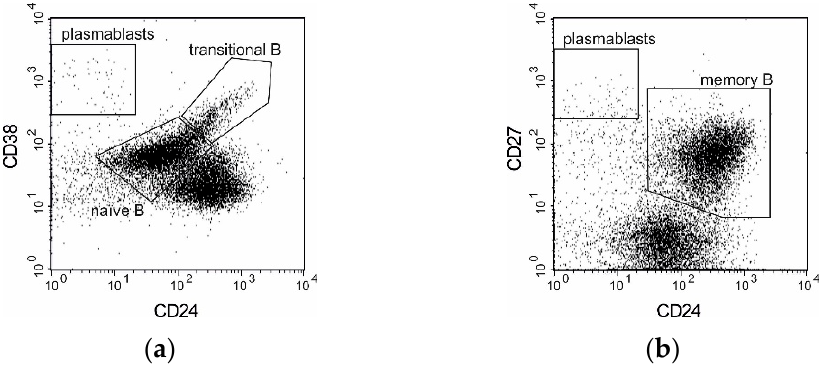
Figure 2. B subpopulations gating strategy. Dot plots generated for CD19 + lymphocytes. ( a ) Gating of transitional and naïve B cells; ( b ) gating of memory B cells; plasmablasts defined as the intersection of gates from both panels.